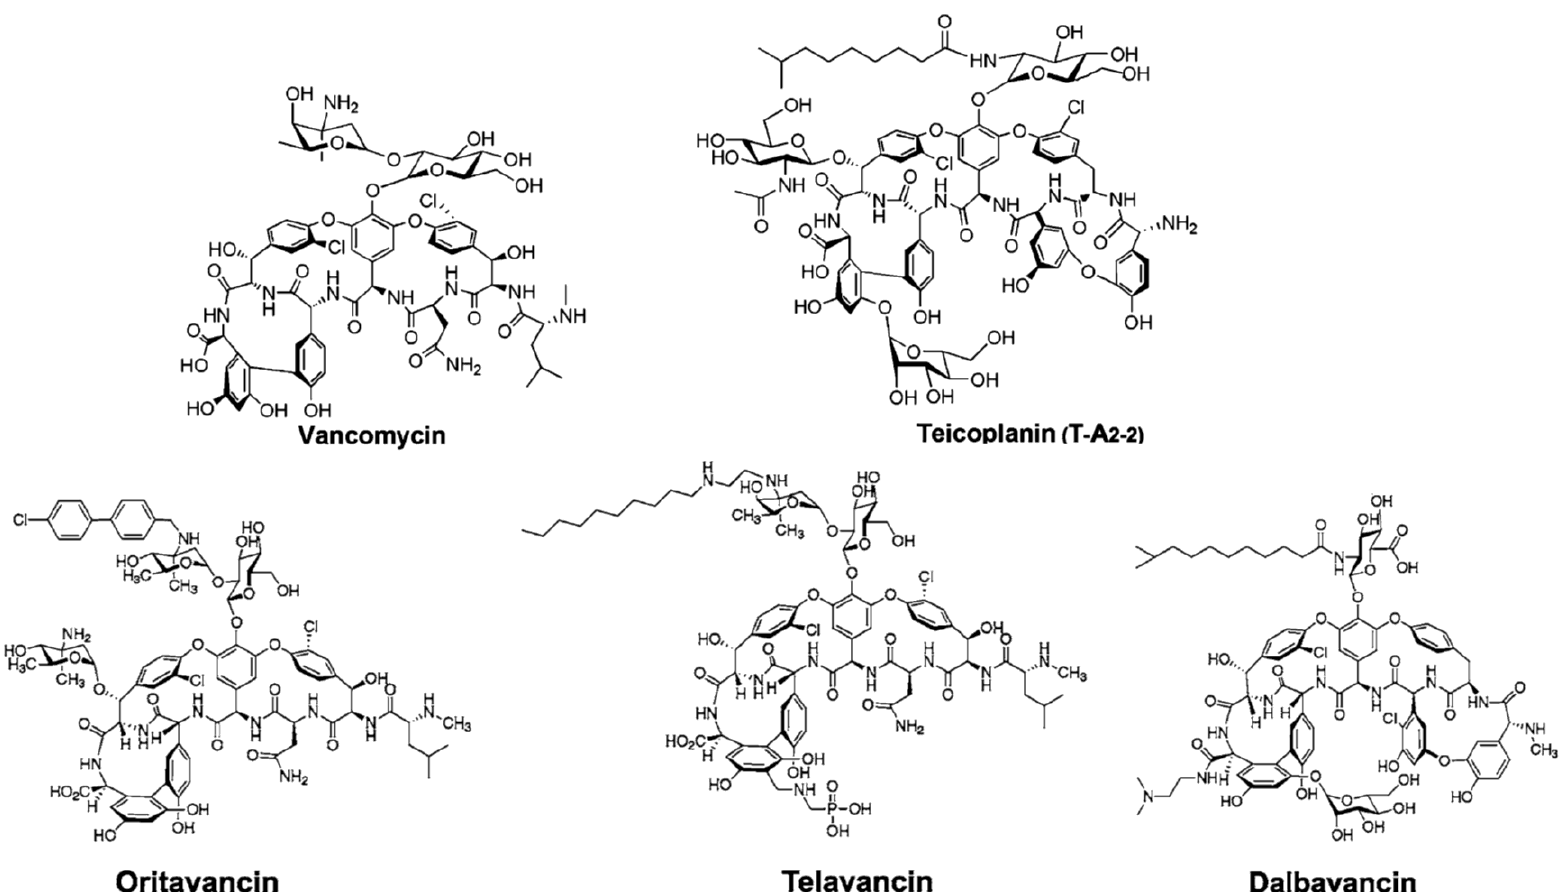
Figure 1. Structures of natural and semi-synthetic glycopeptide antibiotics (GPAs). Vancomycin and teicoplanin are natural products. In the case of teicoplanin, the clinically used antibiotic is a mixture of five lipoglycopeptide molecules differing in the length (C10-C11) and branching of the fatty acid tail, whose main component, the one reported in the figure, bears the 8-methylnonanoic ( iso -C10:0) acid and is named T-A 2-2 . Oritavancin and telavancin are semi-synthetic second generation GPAs belonging to the vancomycin family. Dalbavancin is the semi-synthetic derivative of the teicoplanin-like